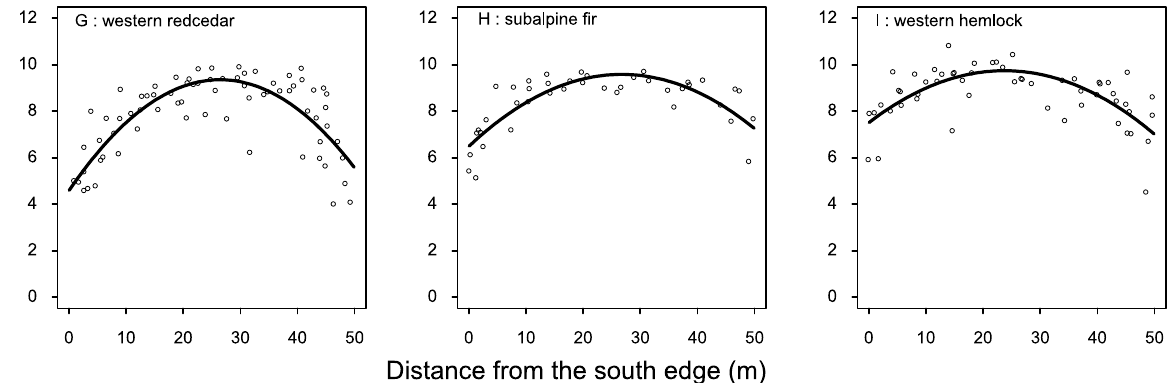
Figure A2. Growth responses of 9 species to the distance from the south edge of the gap (gap-positions). Each point represents individual trees corresponding to Figure 4.